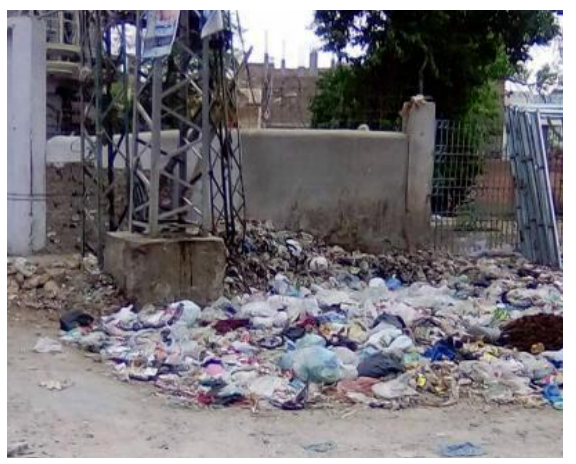
FIG. 5. OPEN DUMPING OF SOLID WASTE BY COMMUNITY ON